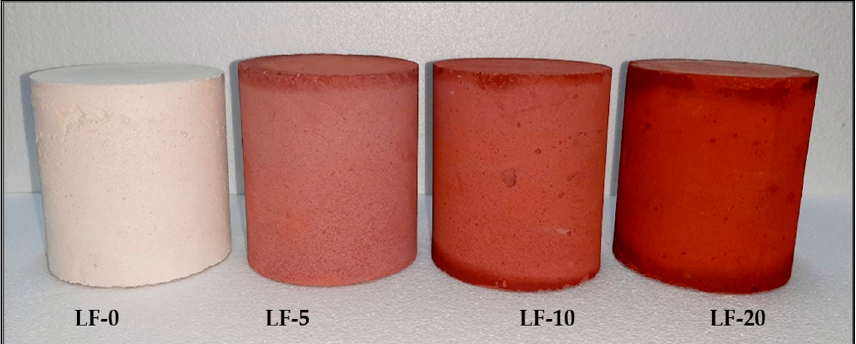
Figure 1. Image of some of the cylindrical samples: LF-0, LF-5, LF-10, and LF-20 (from left to right).